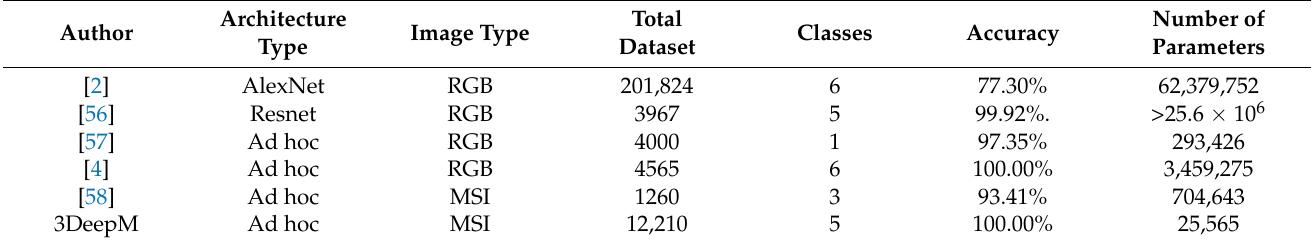
Table 8. Summary of the features of deep learning methods for grape